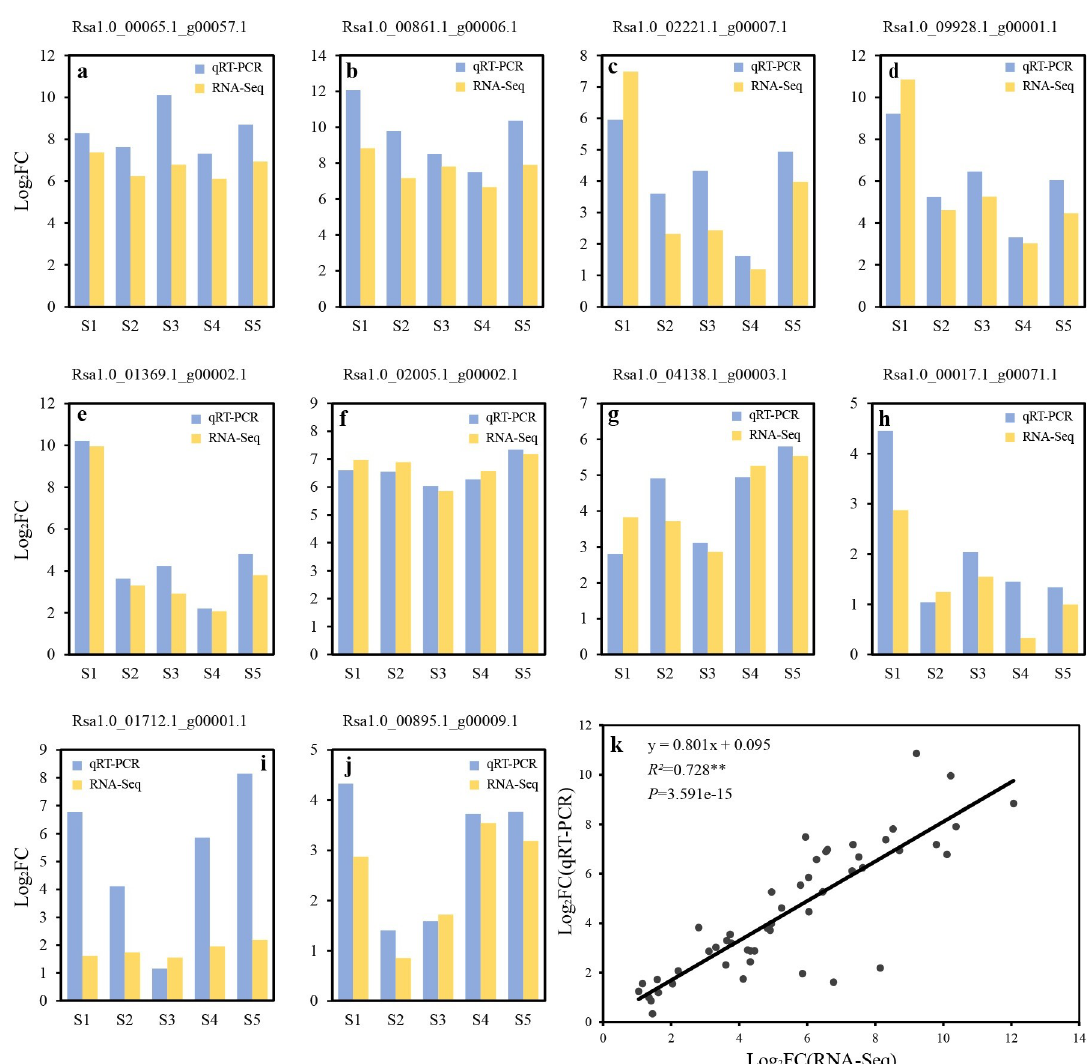
Fig 4. Validation of DEGs by qRT-PCR. a–j , Comparison of the Log 2 FC values of 10 different expressed genes at five development stages between qRT-PCR and RNA-Seq; k , Coefficient analysis of the log 2 FC between data of RNA-Seq (x-axis) and qRT-PCR (y-axis). �� indicates a significant difference at level p �